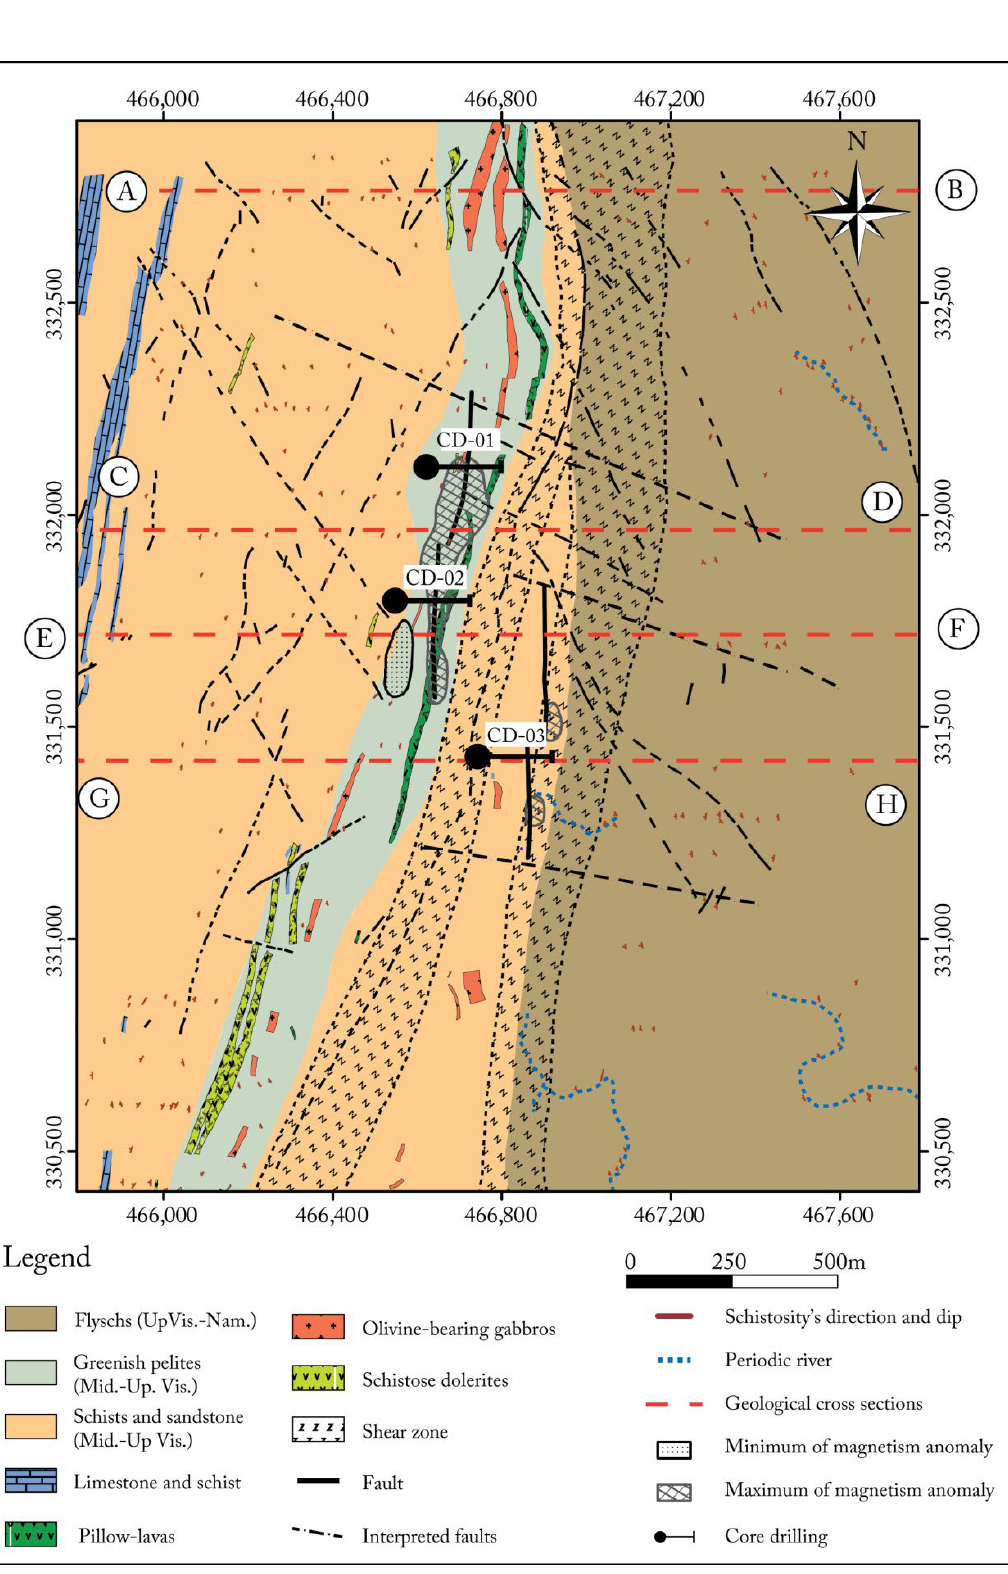
Figure 3. Geological map of the NNE Achemmach. (Mid.-UpVis.—Middle-Upper Visean, UpVis- Nam.—Upper Visean-Namurian). A–H: position of the geological sections.